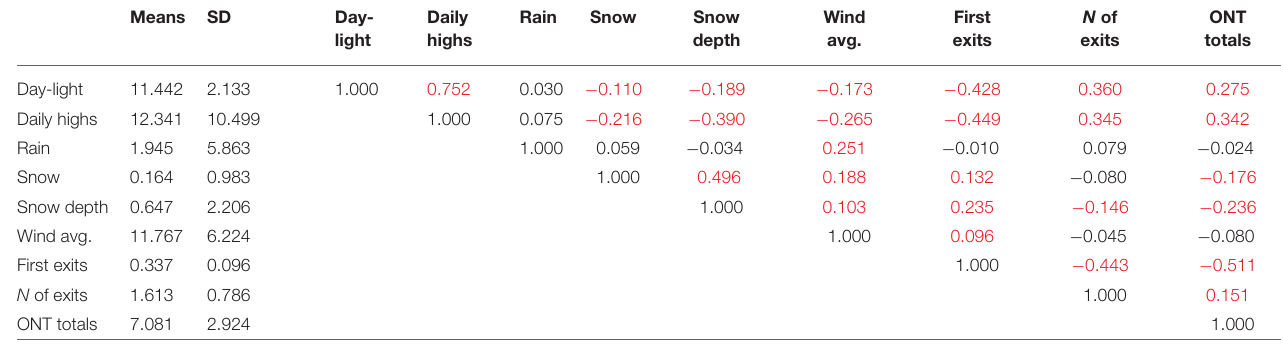
TABLE 2 | Correlation matrix between key climatic factors and dependent variables.